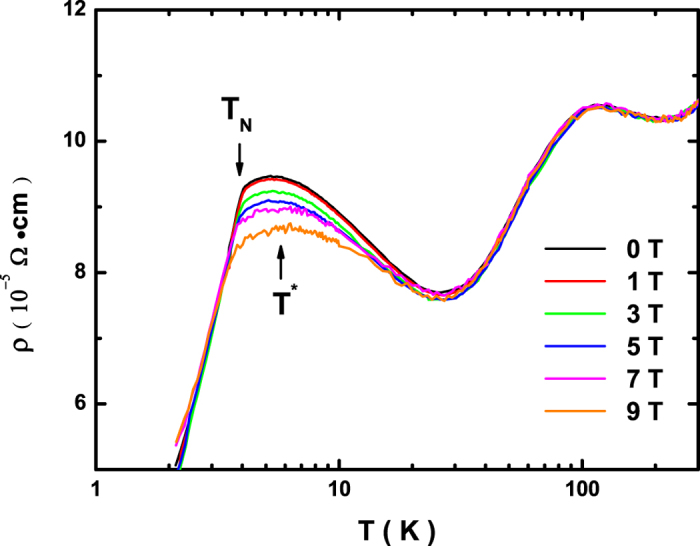
Bulk resistivity of the antiferromagnet CeCu2Ge2 measured under different magnetic fields.